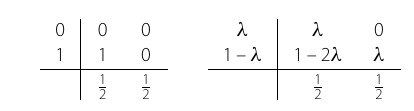
Table 4 Butcher tableaus for the 2nd-order IMEX-RK method (Sect. 5.3.4)